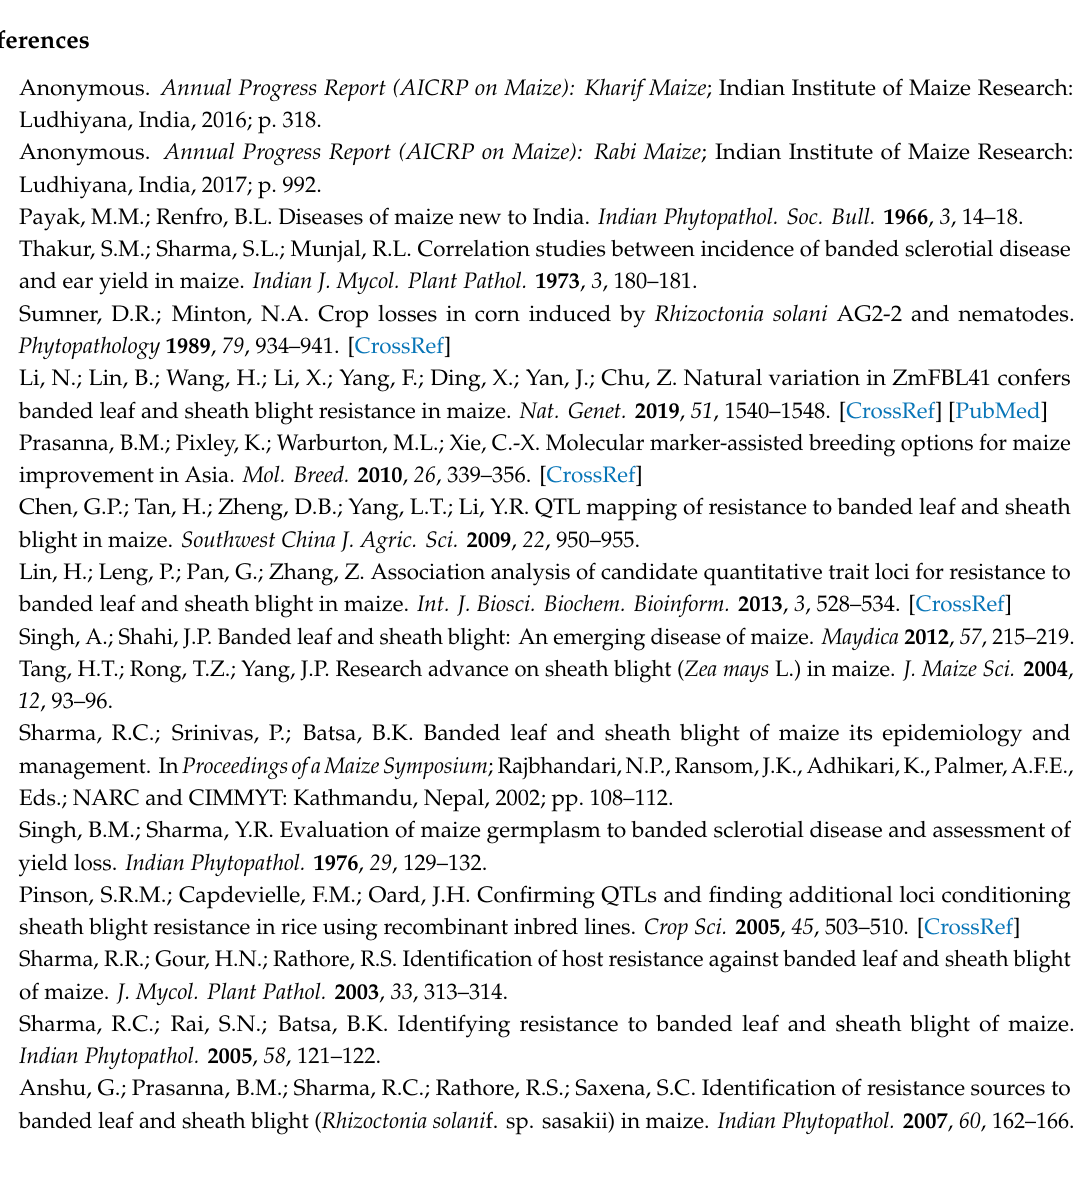
Figure S1: GFP-tagging of Pseudomonas aeruginosa MF-30, Figure S2: Qualitative estimation of plant growth promoting and biocontrol attributes in Pseudomonas aeruginosa MF-30, Table S1: Qualitative estimation of plant growth promoting and biocontrol attributes in Pseudomonas aeruginosa